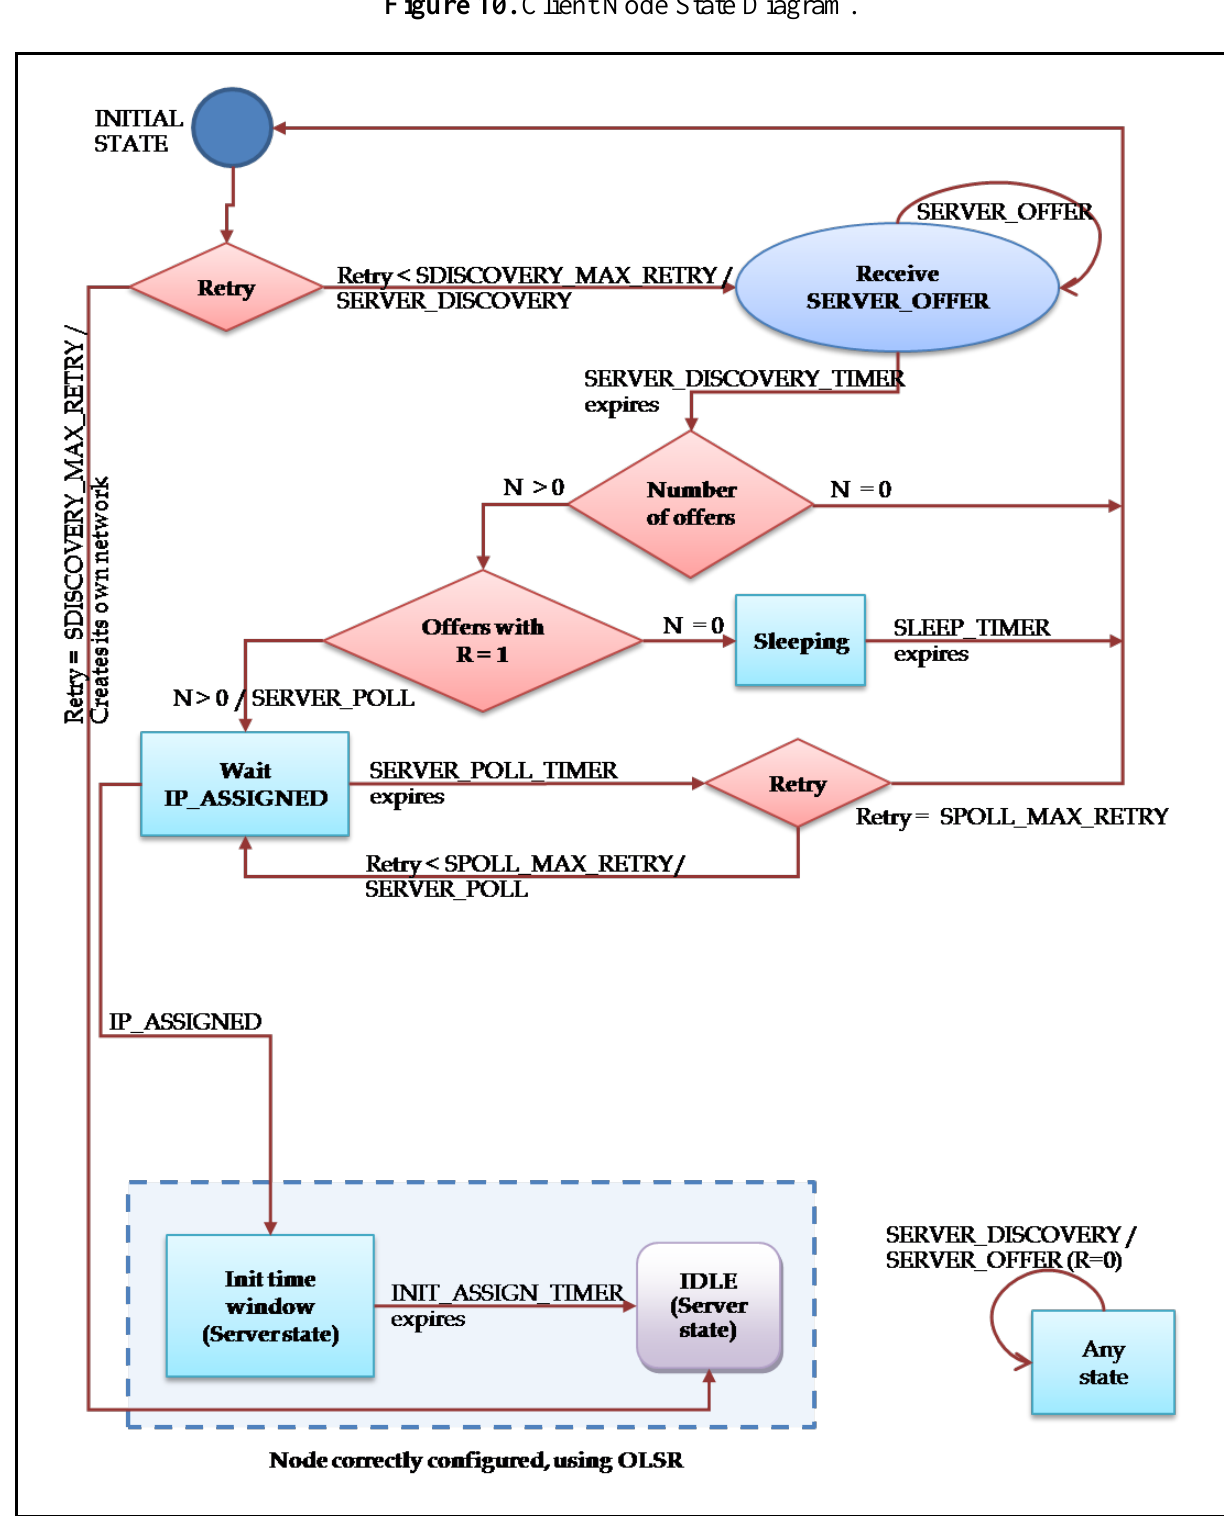
Figure 10. Client Node State